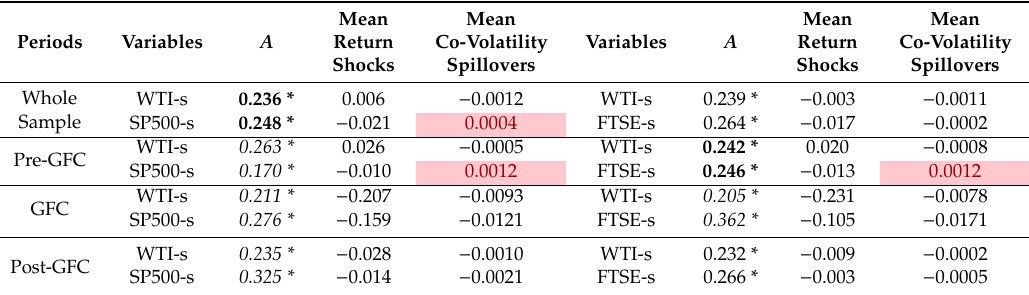
Table 5. Matrix A in Diagonal BEKK, mean return shocks, and mean co-volatility spillovers for UK and US spot markets, four periods (2 ×